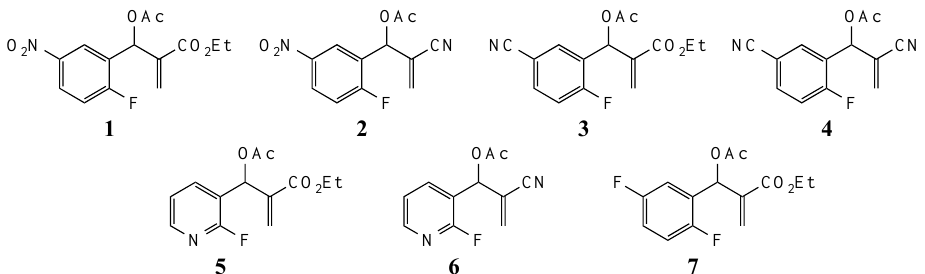
Figure 2. Substrates for the preparation of 3,6-disubstituted 1-alkyl/phenyl-1,2-dihydroquinolines ( 1 – 4 and 7 ), 3-substituted 1-alkyl/phenyl-1,2-dihydro-1,8-naphthyridines ( 5 , 6 ) and quinolones ( 7 ). The results from reactions of 1 – 4 (1 equiv) with primary aliphatic or aromatic amines 8 (1.5 equiv) in DMF (1 h, 23 ◦ C, and 1–5 h, 50 ◦ C) gave the 3,6-disubstituted